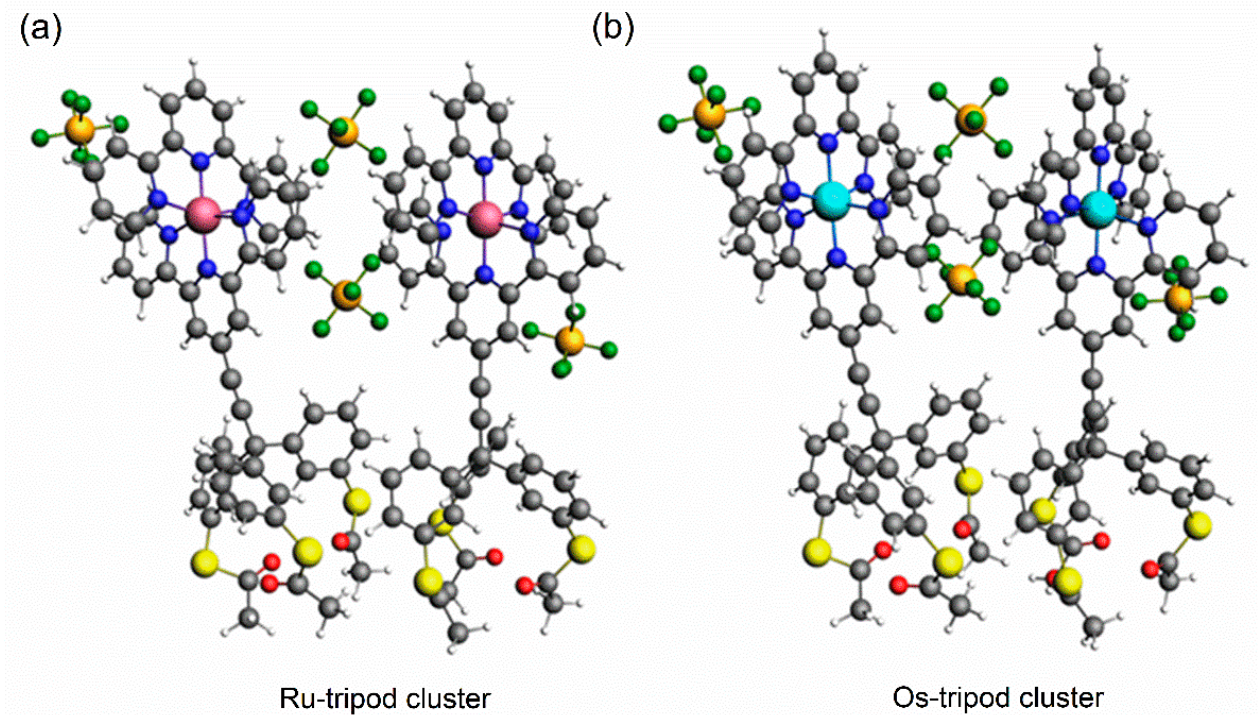
Figure 6. Geometry-optimized cluster of ( a ) Ru-tripod ; and ( b ) Os-tripod molecules containing acetyl-protected thiolates.